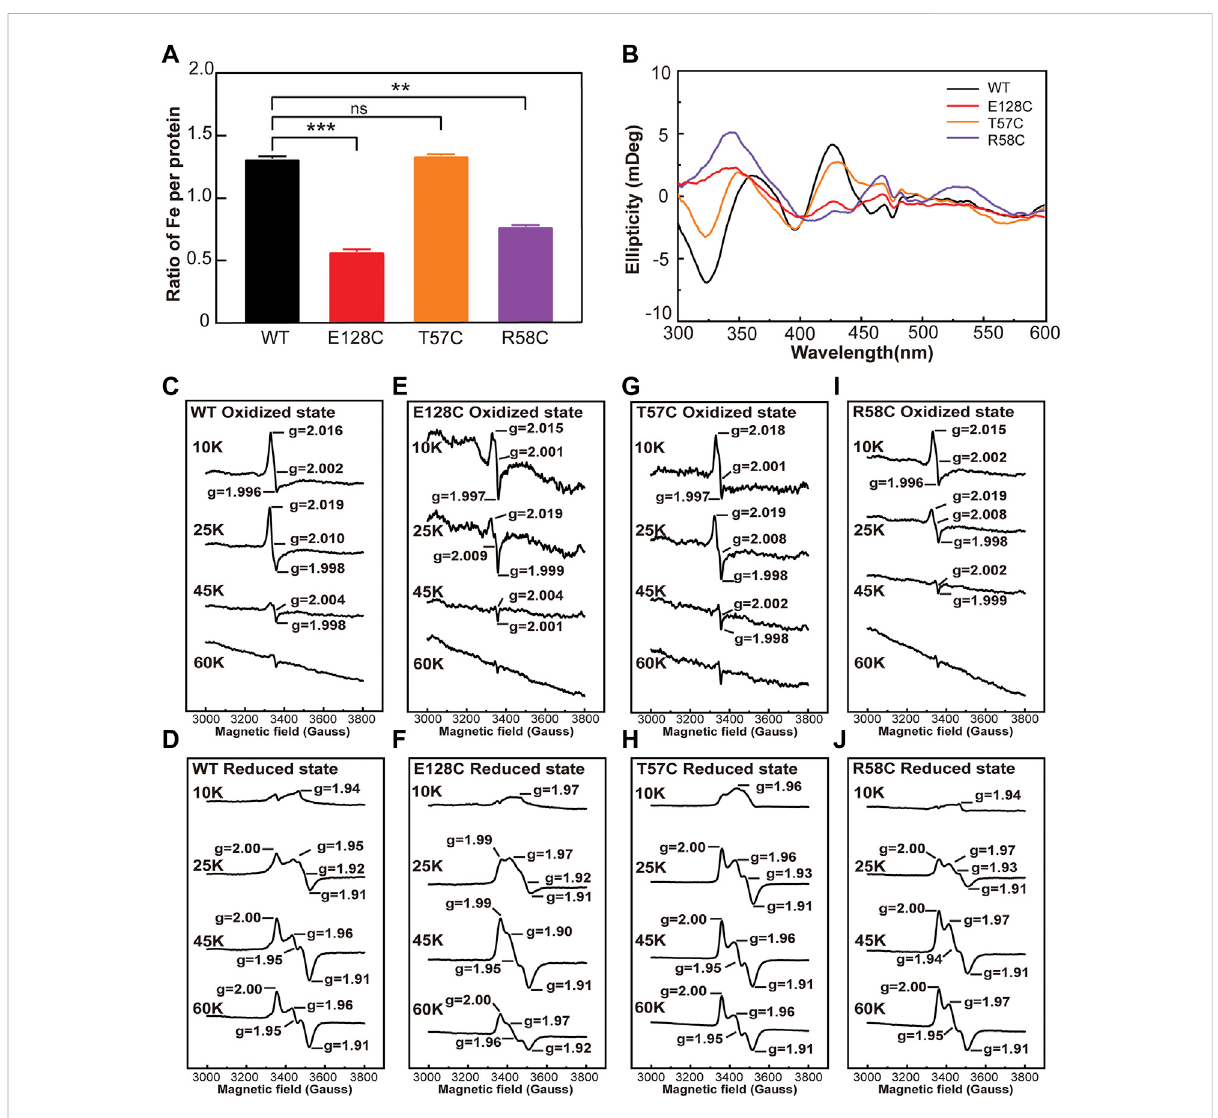
FIGURE 4 Theironcontentandthetypeofiron-sulfurclusterofwildtypeclMagRanditsmutants. (A) Ironcontentofpuri fi edwildtypeclMagR(WT,black) and itsmutants measuredbyFerrozineassay andpresented astheratio ofiron atoms ineach protein. Student ’ st-test:**, p < 0.01;***, p < 0.001; ns, p > 0.05, “ ns ” indicatenosigni fi cantdifferences.Errorbars:SDofthreeexperiments. (B) Circulardichroism(CD)spectrumofwildtypeclMagRandits mutants. (C – J) EPRspectrumofwildtypeclMagR(WT, C,D )anditsmutants,E128C (E,F) ,T57C (G,H) andR58C (I,J) .EPRweremeasuredbothat oxidized (upper) status and reduced status (lower), and recorded at different temperatures (10 K, 25 K, 45 K and 60 K). Asterisks above bars indicate statistically signi fi cant differences between treatments